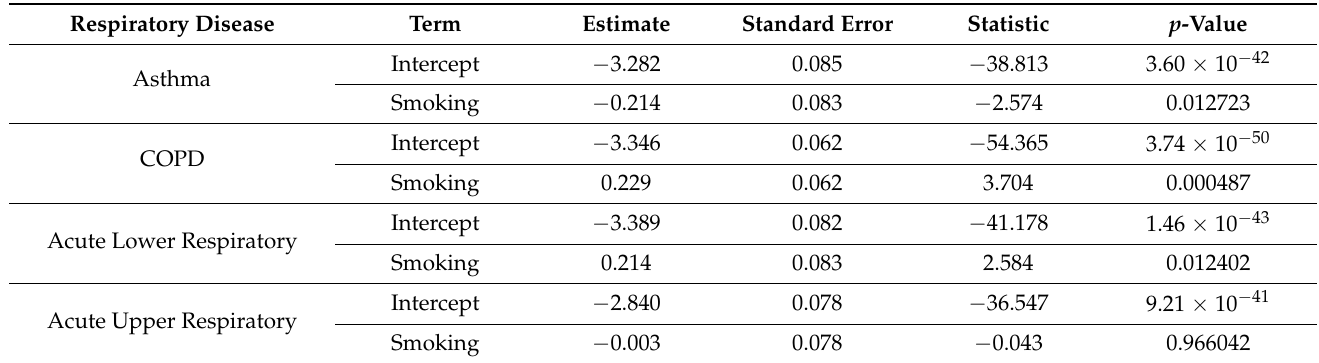
Table 5. The association between air pollution and respiratory diseases adjusted for smoking and poverty.